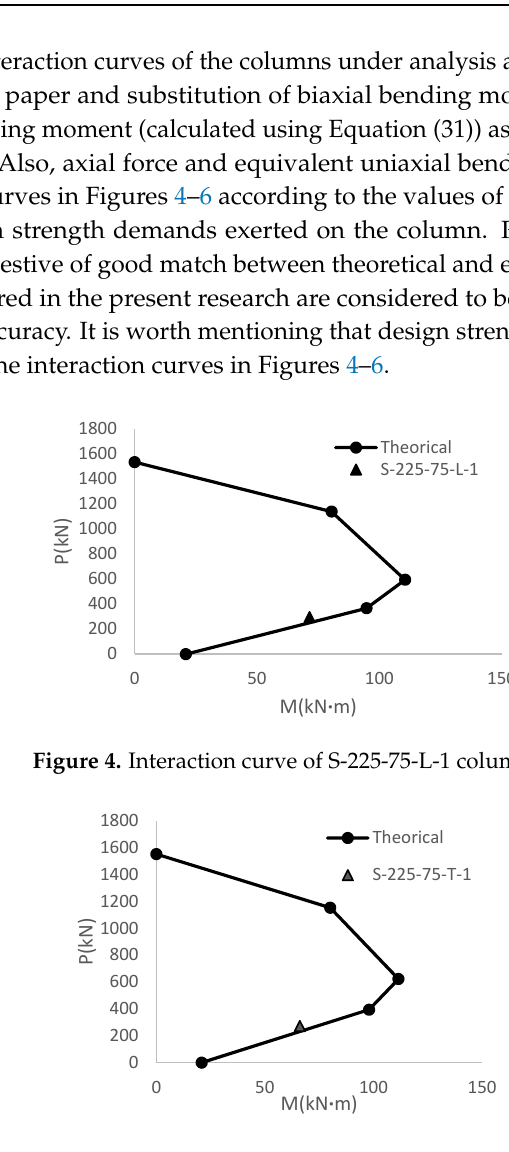
Table 3. Failure (ultimate) loading results of the columns studied by Rahai and Akbarpour [2].